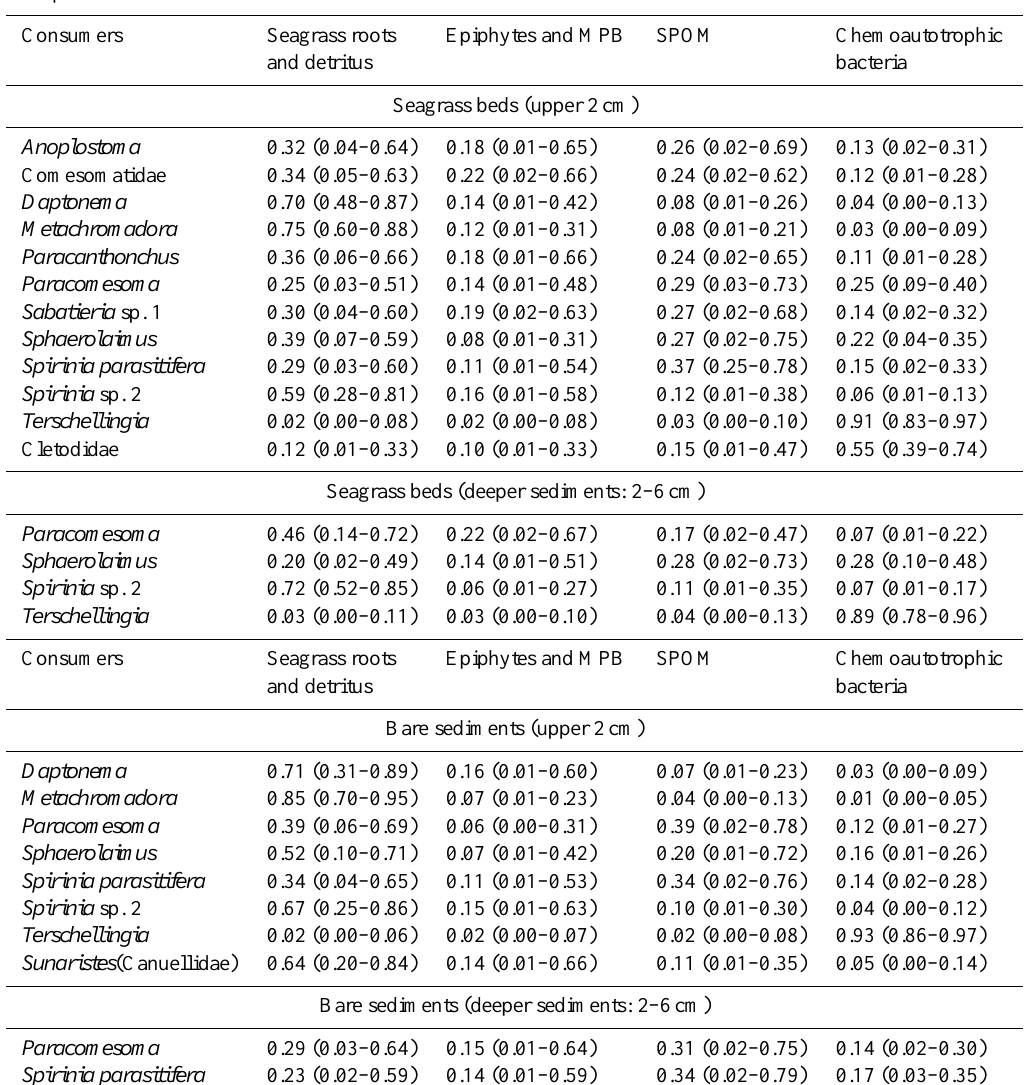
Table 3. Proportional contributions per unit of each resource to the carbon requirements of meiofauna taxa in seagrass beds and bare sediments, in the surface (2cm) and deeper sediments (2–6cm), as computed by the isotope mixing model MixSIR (values given as median and lower to upper limits of 95% confidence intervals). MPB stands for microphytobenthos and SPOM for suspended particulate organic